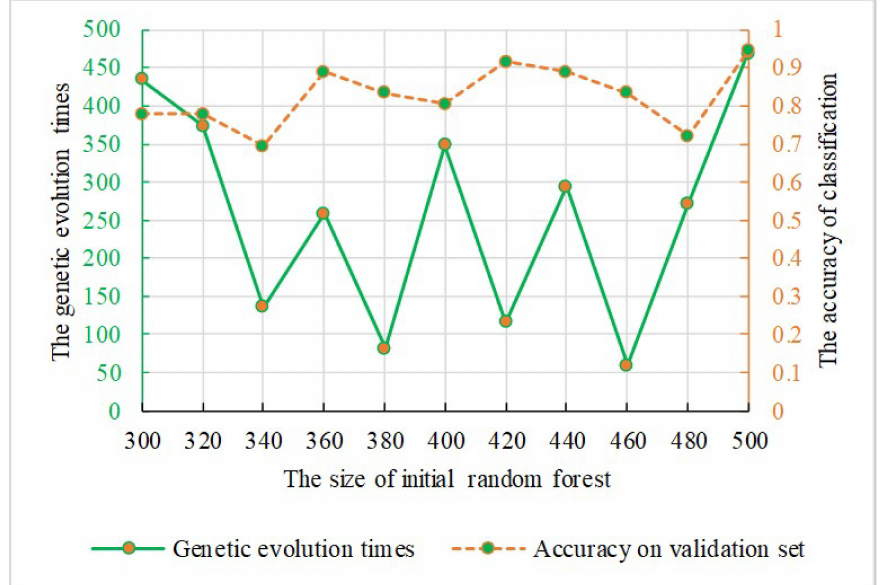
Figure 7. The relationship between the genetic evolution times and the size of initial random forest. Clustering Evolutionary Random